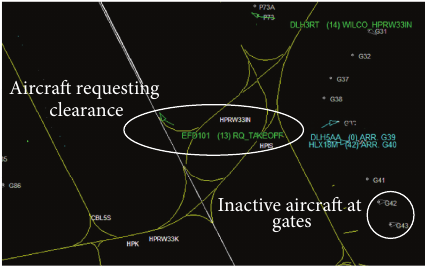
Figure 12: NAVSIM ATC simulated radar display. Aircraft request- ing clearances are highlighted in color. Inactive aircraft are muted in